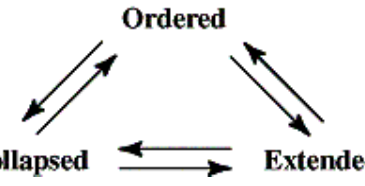
FIGURE 1. The Protein